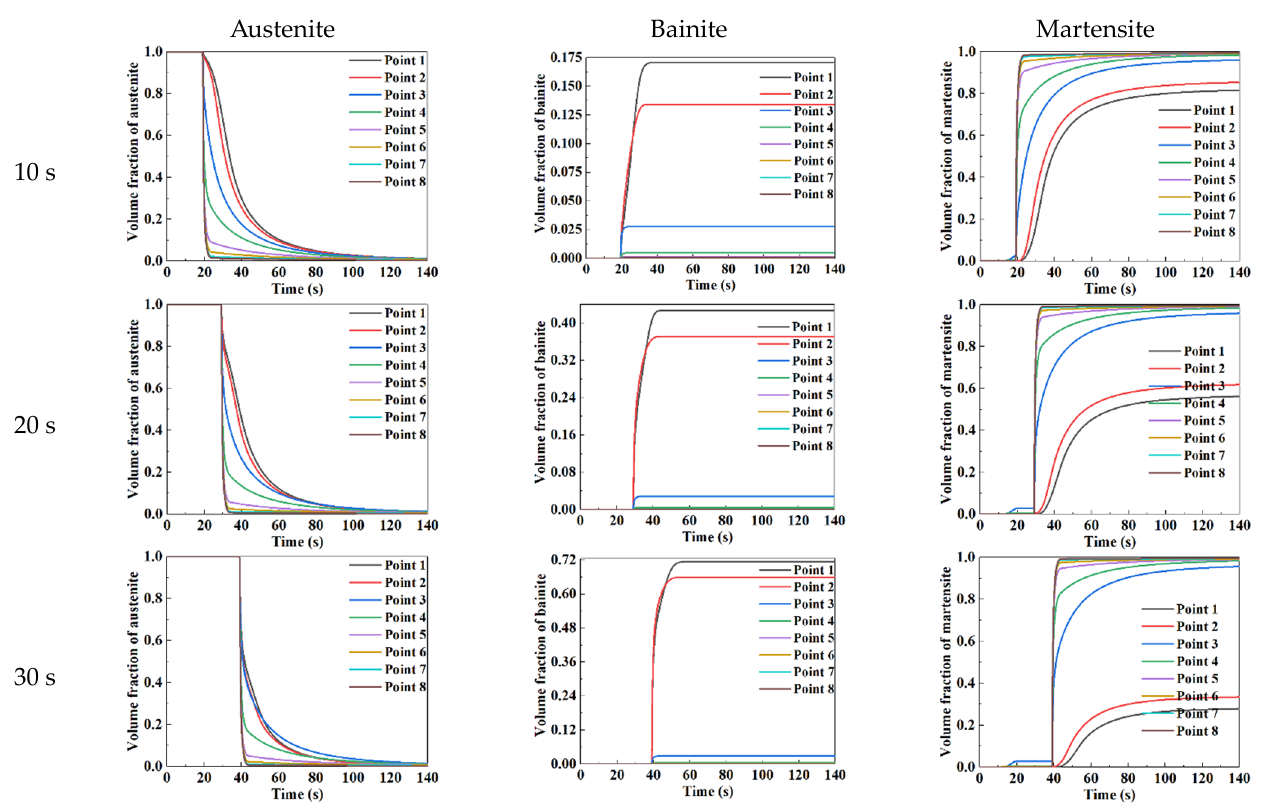
Figure 10. Variation of volume fraction of austenite, bainite, and martensite with time under different quenching time.